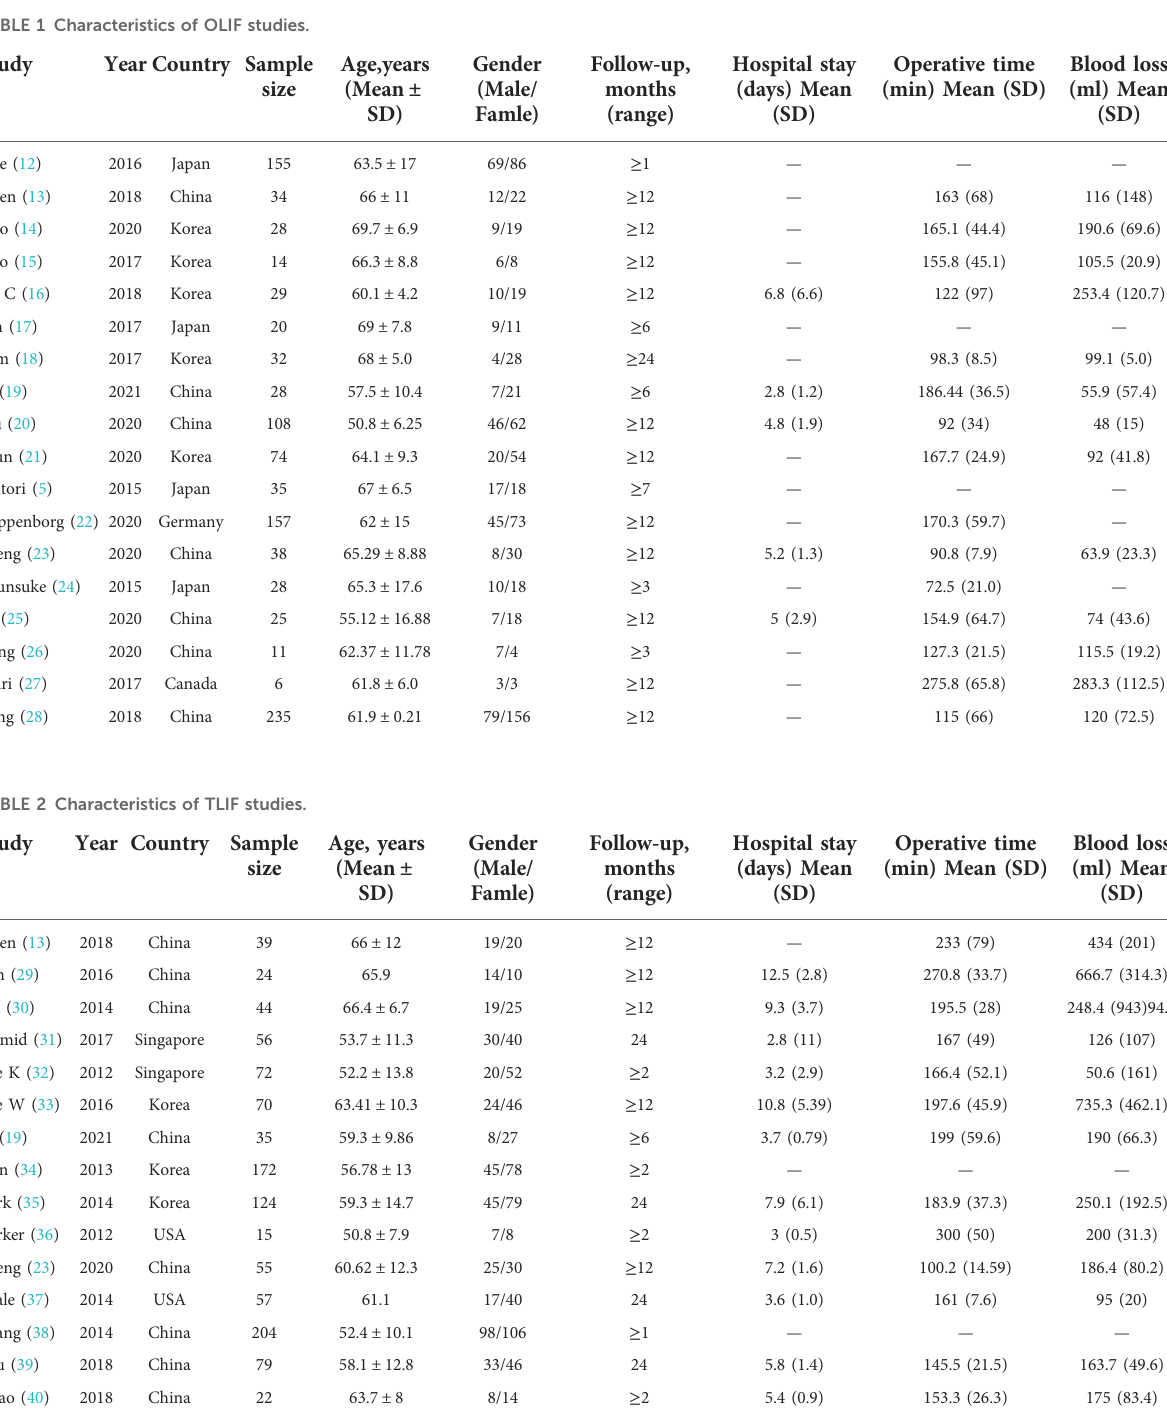
TABLE 1 Characteristics of OLIF studies.